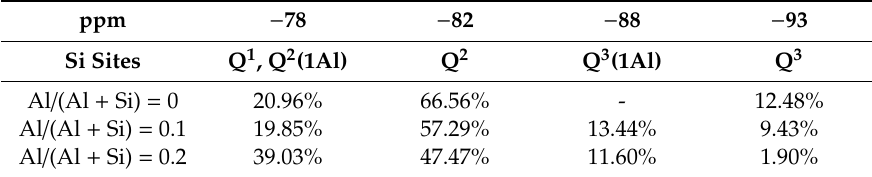
Table 1. Relative content of each resonance peak in 29 Si